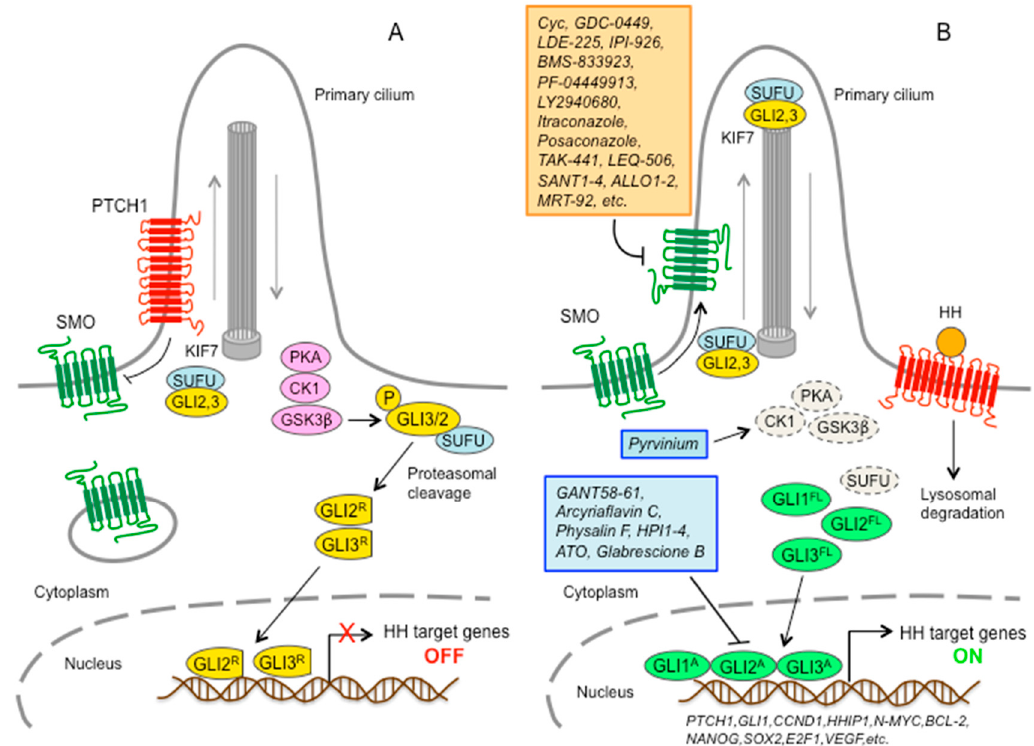
Figure 1. Overview of the Hedgehog-GLI pathway with SMO and GLI antagonists. In absence of HH ligands ( A ), PTCH1 inhibits SMO by preventing its entry into the primary cilium (PC). GLI2 and GLI3 proteins are sequestered in the cytoplasm by SUFU and phosphorylated by PKA, GSK3 β , and CK1, which create binding sites for the E3 ubiquitin ligase β -TrCP ( β -Transducin Repeat-Containing Protein). GLI3 and, to a lesser extent, GLI2 undergo partial proteasome degradation, leading to the formation of repressor forms (GLI3 R /2 R ) that translocate into the nucleus where they inhibit the transcription of HH target genes. Upon HH ligand binding ( B ), PTCH1 is displaced from the PC, allowing accumulation and activation of SMO. Active SMO relieves SUFU-mediated suppression of GLI2 and GLI3 within the PC. GLI2 and GLI3 maintain their full-length status and bypass phosphorylation. Activator forms of GLI (GLI1 A /2 A /3 A ) translocate into the nucleus, where they induce the transcription of HH pathway target genes. Movement of GLI2 and GLI3 within the PC occurs in conjunction with KIF7, a member of the kinesin family of anterograde motor proteins. SMO (orange box) and GLI (light blue box) antagonists are indicated in ( B ). GLI inhibitor Pyrvinium enhances CK1 α -dependent degradation of GLI A . CK1, casein kinase 1; GSK3 β , glycogen synthase kinase 3 β ; PKA, protein kinase A; PTCH1, Patched 1; SMO, Smoothened; SUFU, Suppressor of Fused; HH, Hedgehog; KIF7, kinesin family member 7; ATO, arsenic trioxide.